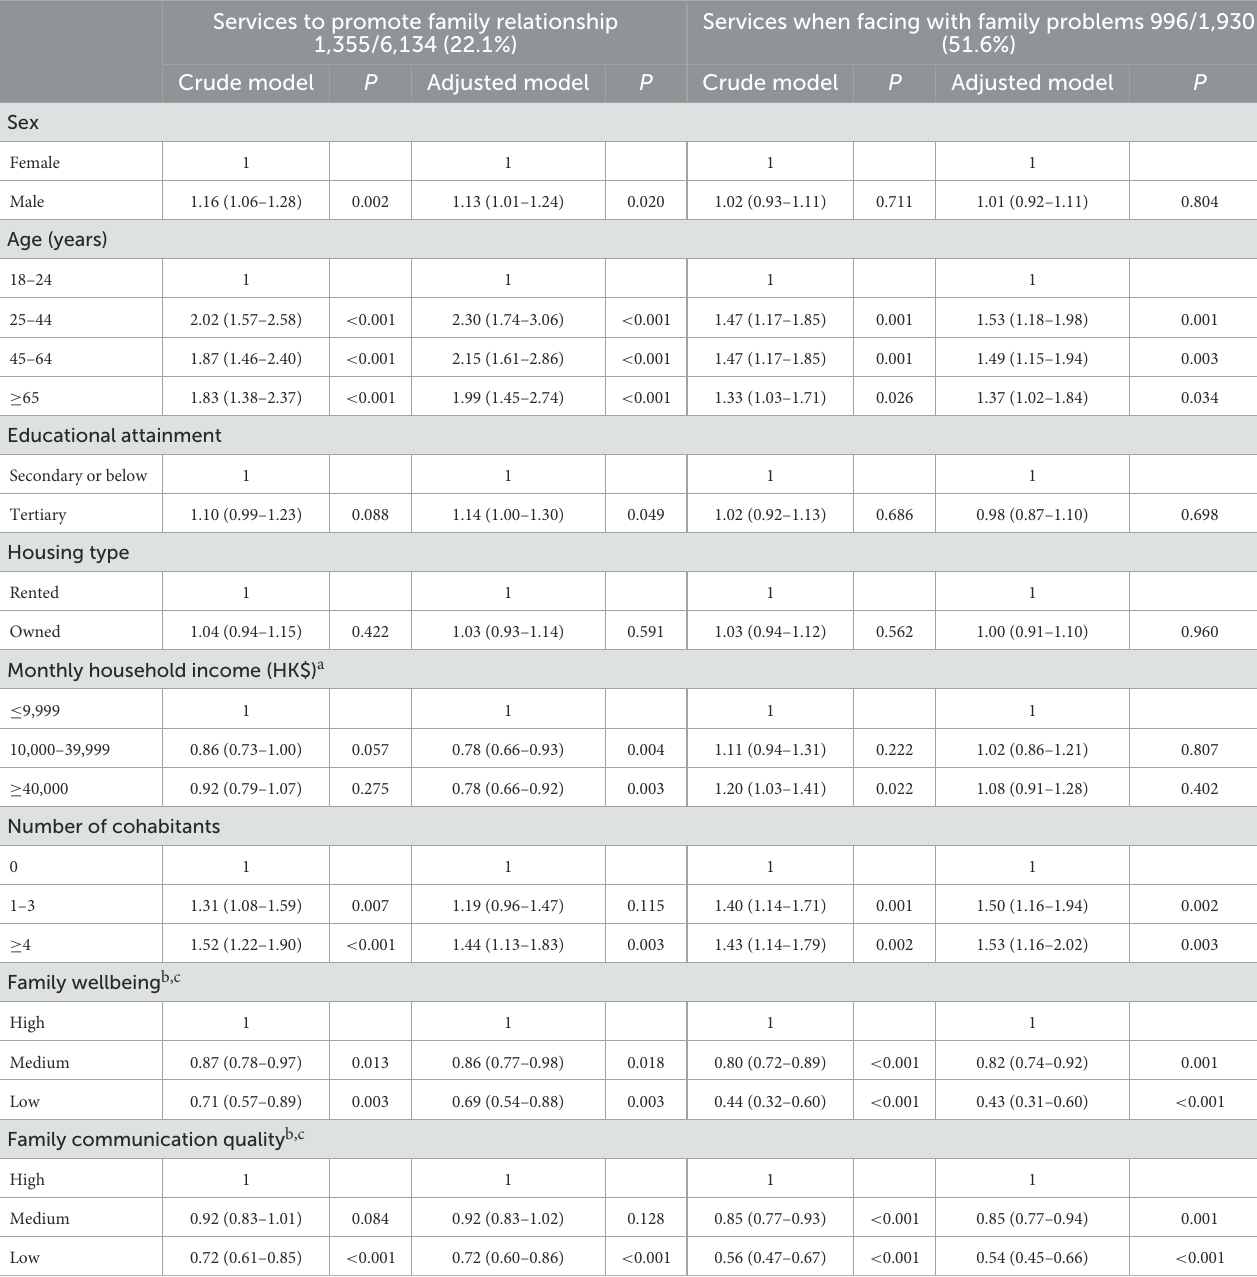
TABLE 2 The associations of willingness to attend family services with sociodemographic characteristics, family wellbeing, and family communication quality, PR (95% CI). Services to promote family relationship Services when facing with family problems 996/1,930 1,355/6,134 (22.1%)